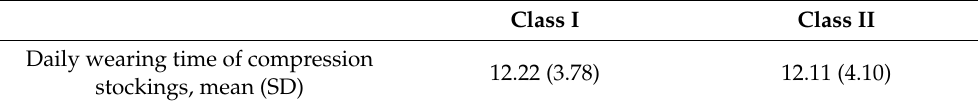
Table 5. Mean and range of wearing time (hours per day) of the medical device.